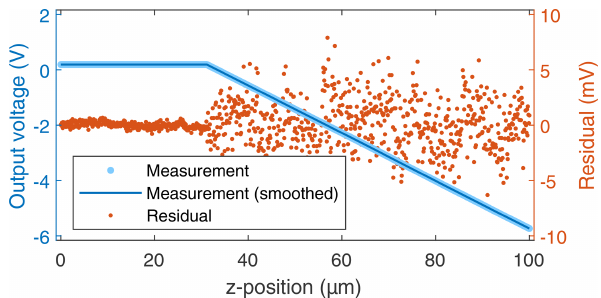
Figure 5. Quasi-static voltage-displacement curve. Measured val- ues (light blue dots) and smoothed curve (dark blue line). To illus- trate the agreement between measurement and extracted informa- tion, residuals are shown as red dots on a magnified scale given on the right ordinate.